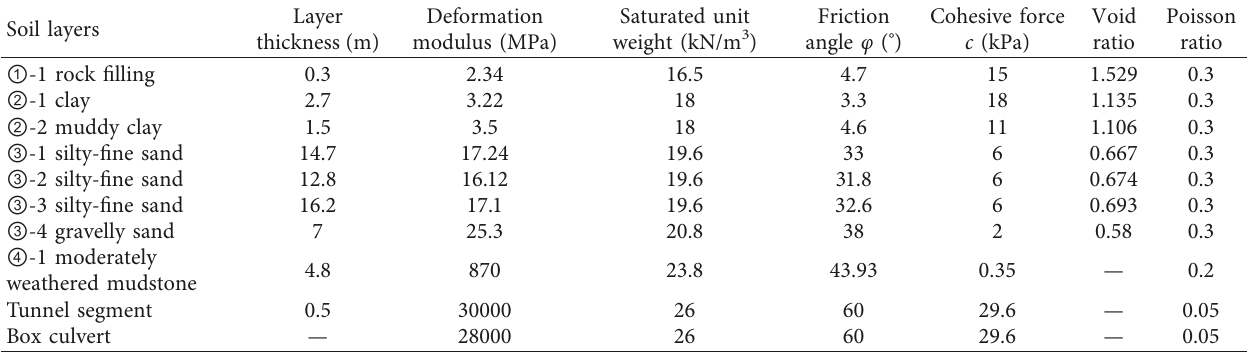
Table 1: Parameters of soil layers and the tunnel.